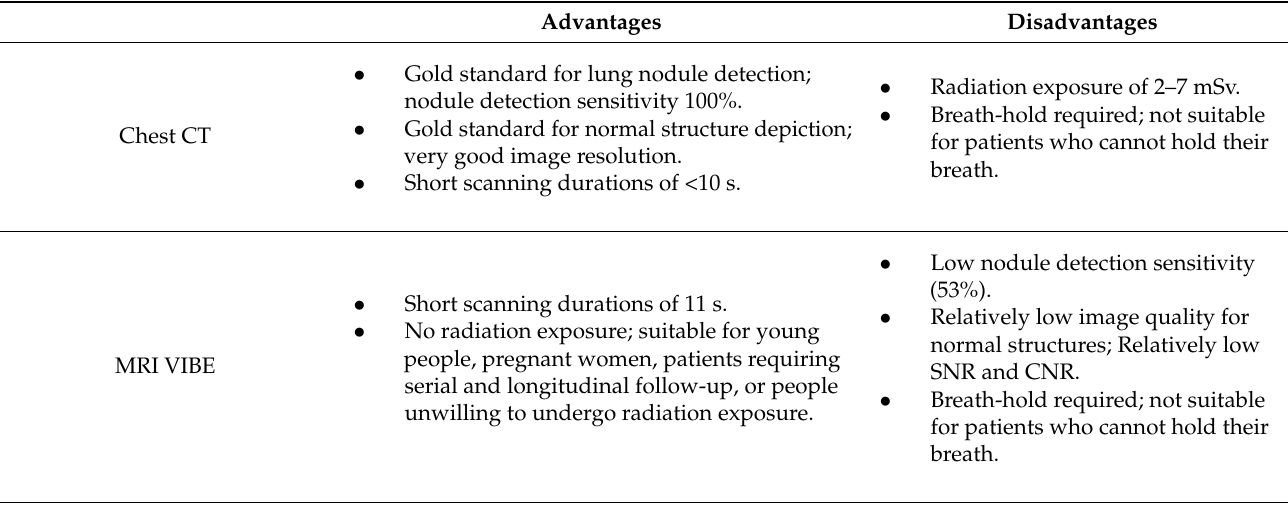
Table 5. Advantages and disadvantages of the proposed imaging